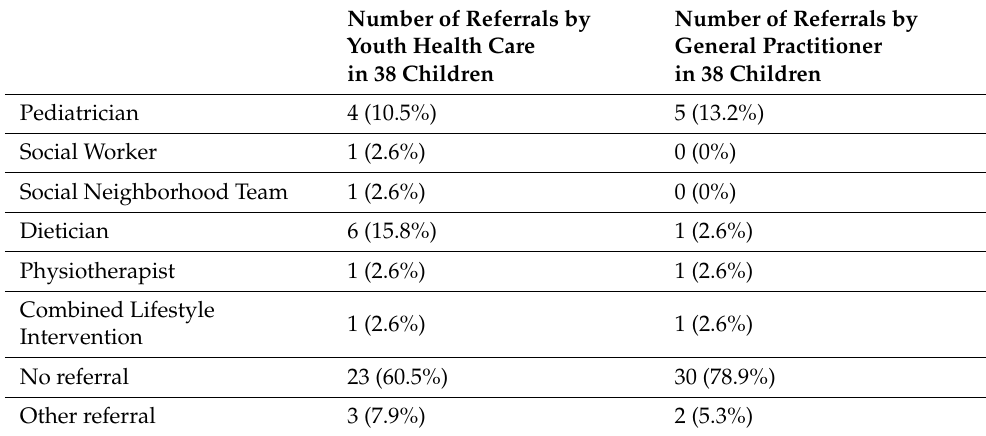
Table 3. Number of children referred to other professionals in the ICCO questionnaire group ( n = 38) by Youth health Care and General